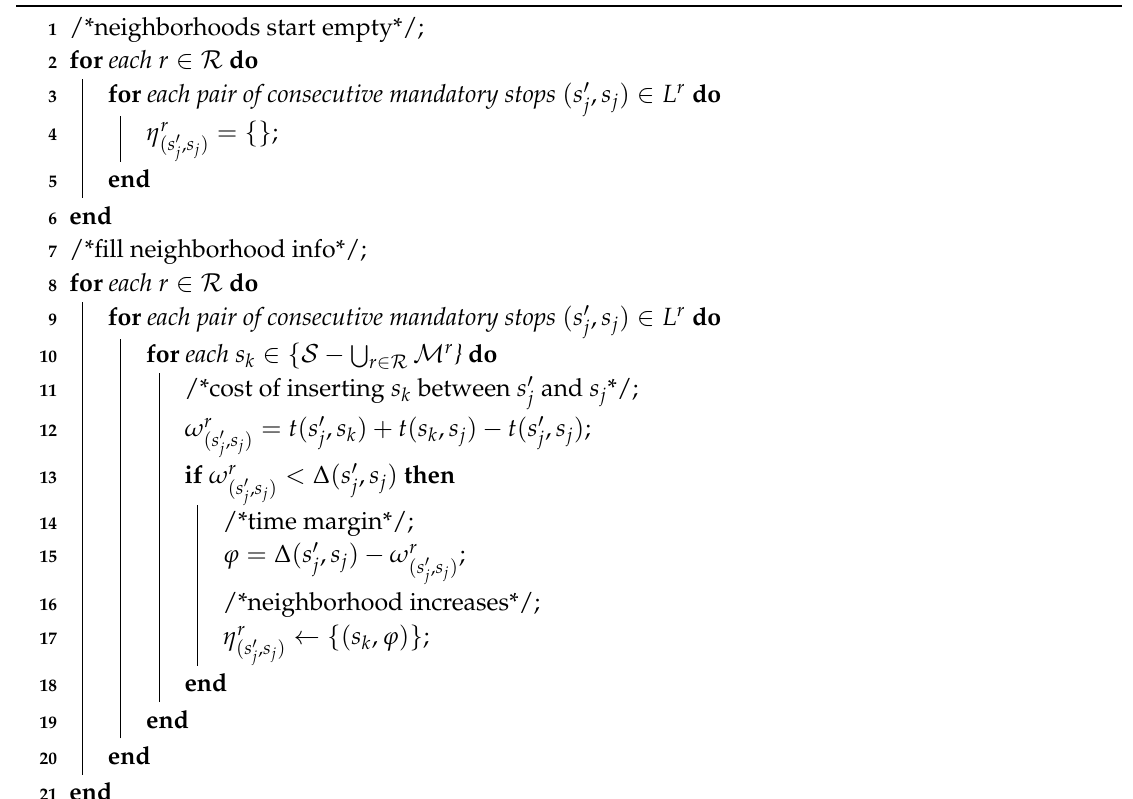
Algorithm 2: Procedure for neighborhood